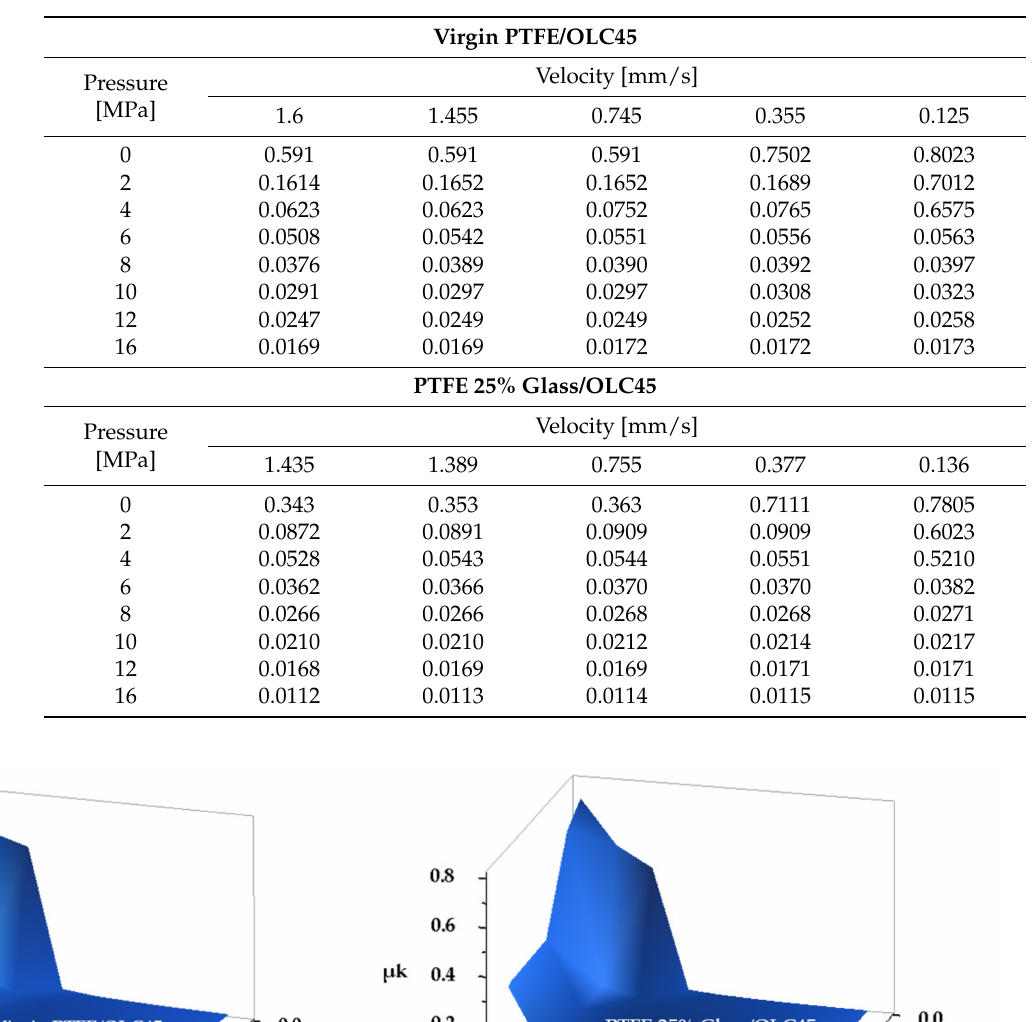
Table 3. Dependency of µ kmin on contact pressure and velocity.